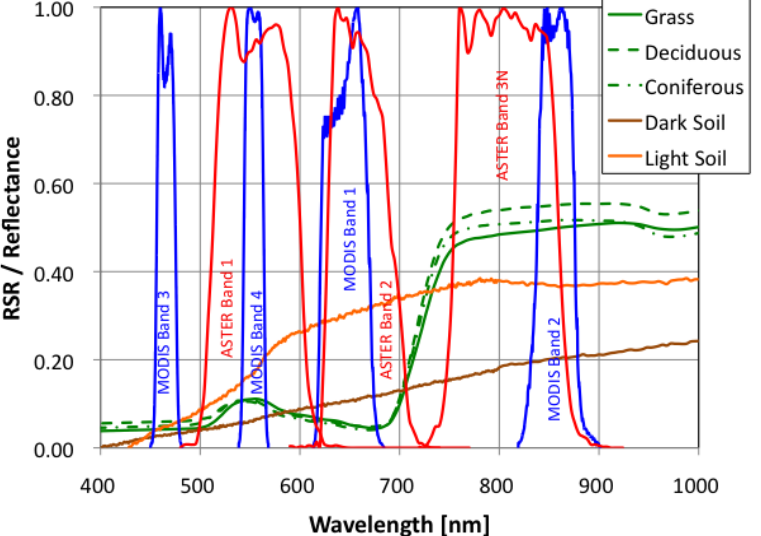
Figure 1. Normalized spectral response functions of select Advanced Spaceborne Thermal Emission and Reflection Radometer (ASTER) and Moderate Resolution Imaging Spectroradiometer (MODIS) bands. The sample reflectance spectra of vegetation and soils in the figure are obtained from the ASTER spectral library